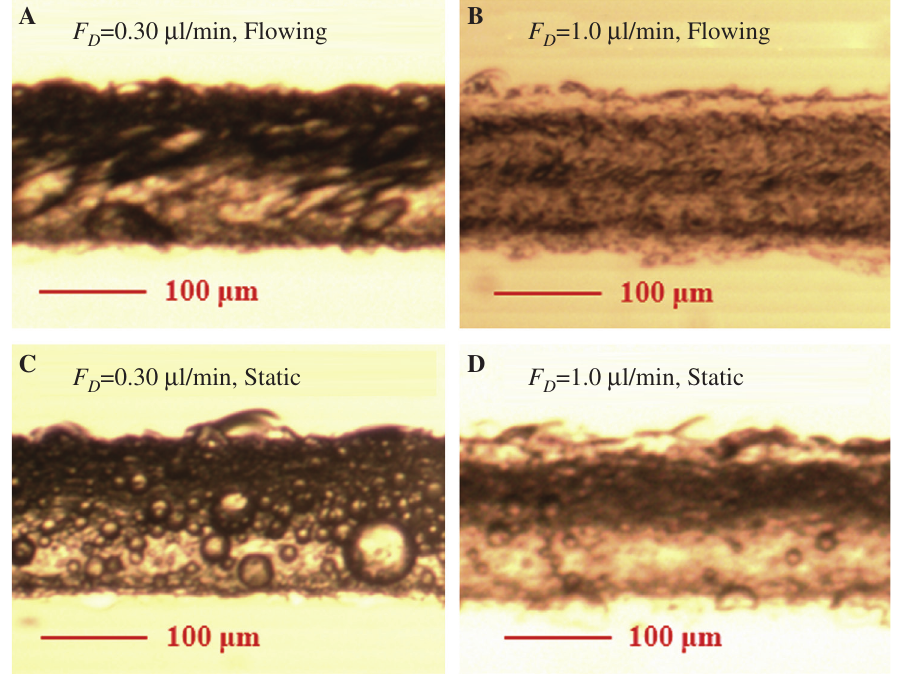
Figure 5 Photographs of mineral oil-seawater phase separation (with Model Dispersant I) through a microfluidic device under flow, (A) = 0.30 μ l/min and (B) F F D min for all tests.